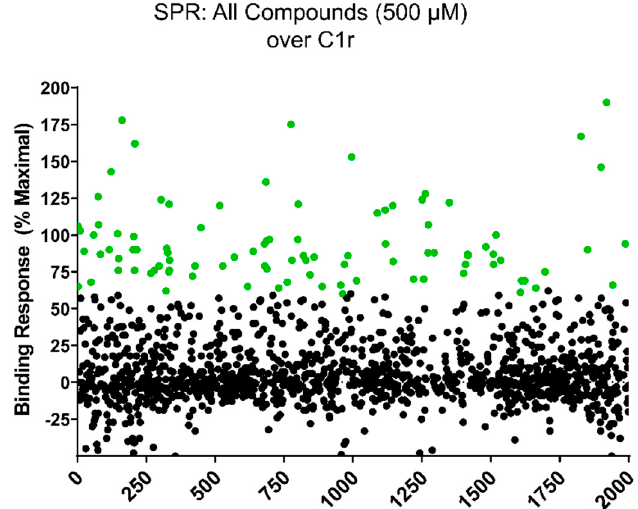
Figure 2. Direct binding of compounds to full-length C1r by SPR. A 2000-compound library was screened at 500 µM final compound concentration for solubility in SPR buffer and for non-specific binding to a blank sensor chip surface (i.e., ‘clean screen’). A total of 1619 compounds were soluble and exhibited low non-specific binding capacity in our SPR assay system. The ability of each of these compounds to bind directly to C1r was measured by injecting a 500 µM final compound concentration over immobilized full-length C1r. A molecular weight corrected theoretical maximal binding response (R max ) for each compound was calculated and compounds that exhibited superstoichiometric binding (i.e., > 2 × R max ) were eliminated from further consideration. In total, 95 compounds exhibited ≥ 60% R max (green circles).